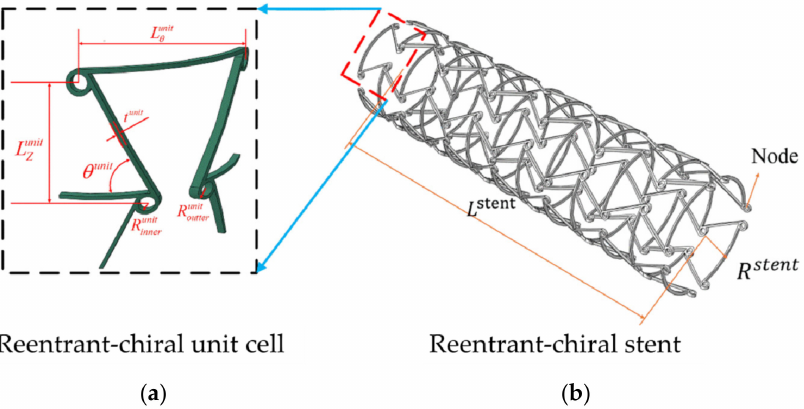
Figure 16. Reentrant-chiral stent [117,118]. ( a ) Reentrant-chiral unit cell, ( b ) Reentrant-chiral stent.